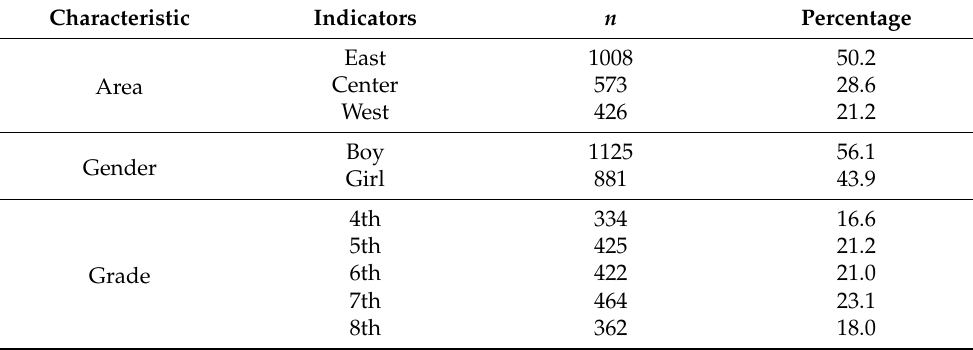
Table 1. Basic sample demographics (N =